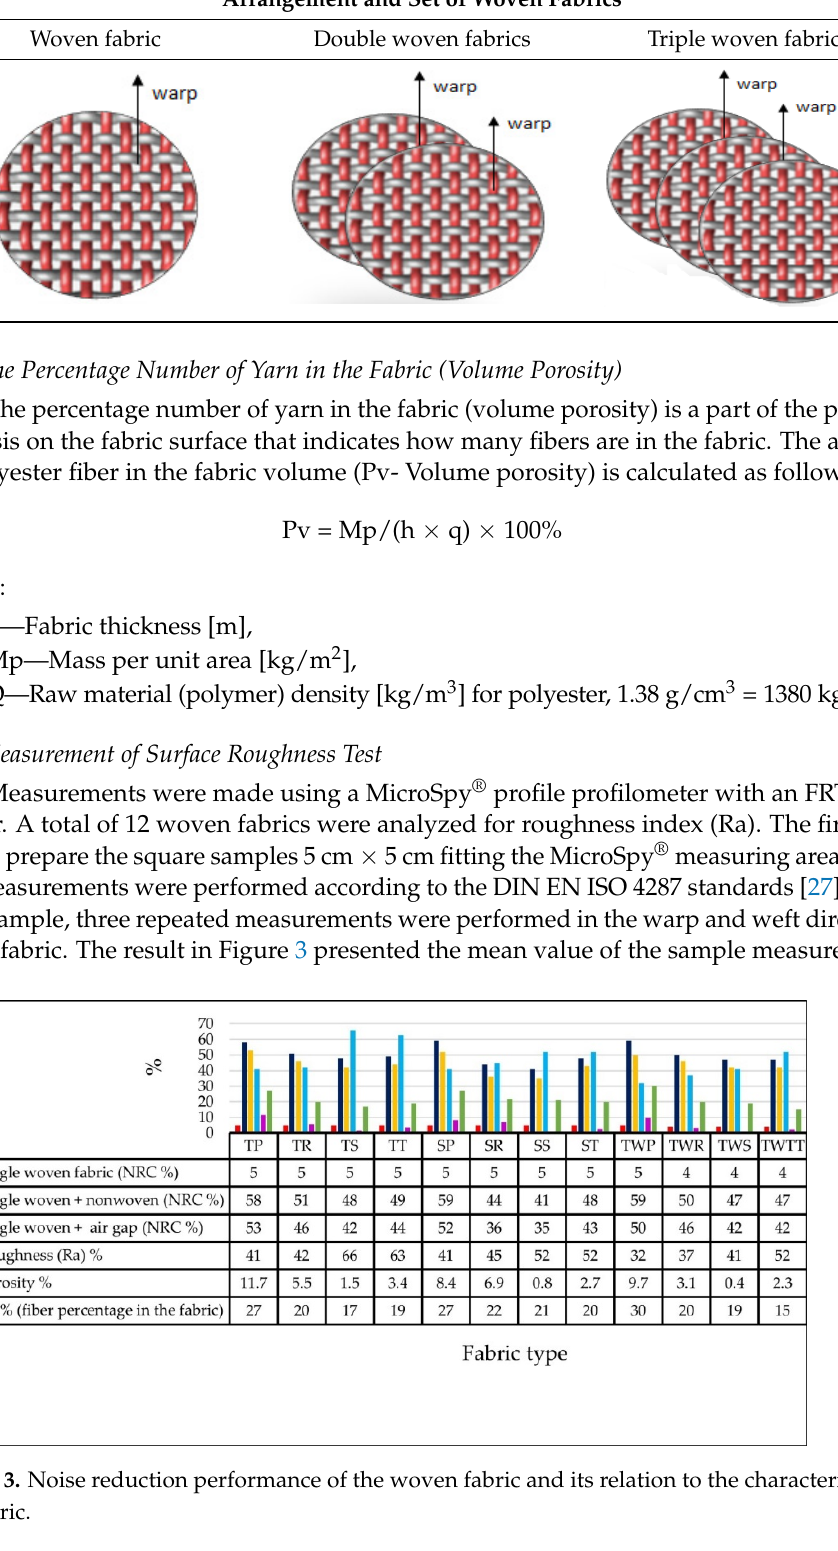
Table 3. Arrangement and setting of woven fabrics. Arrangement and Set of Woven Fabrics